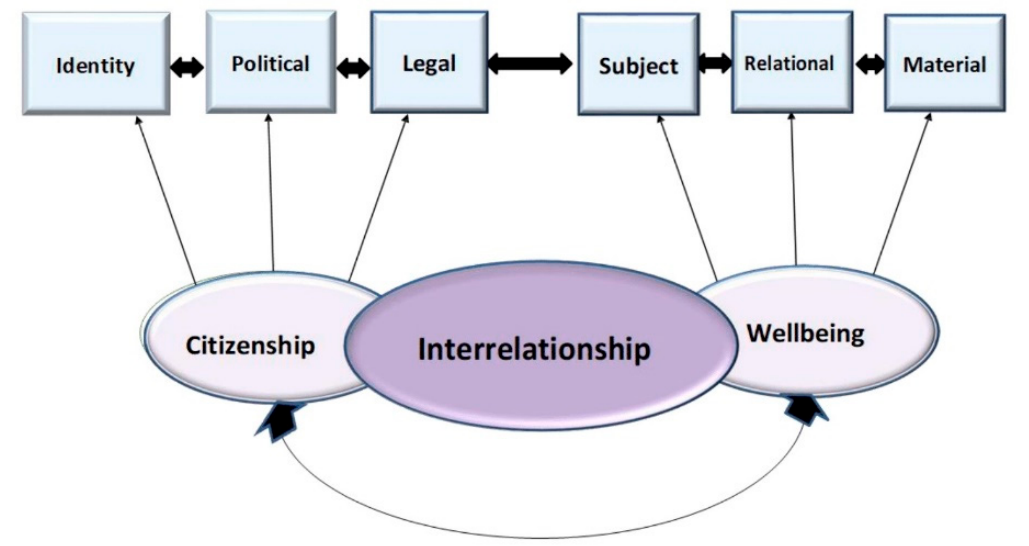
Figure 1. Multidimensional Model